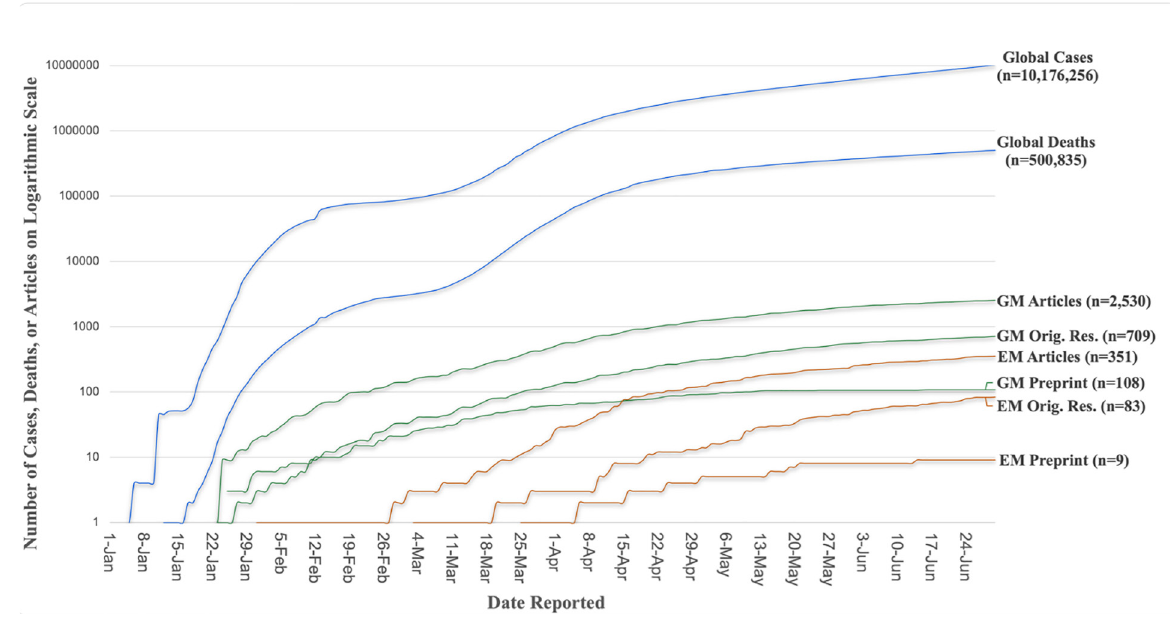
Figure. Global COVID-19 cases and deaths compared to journal publications over